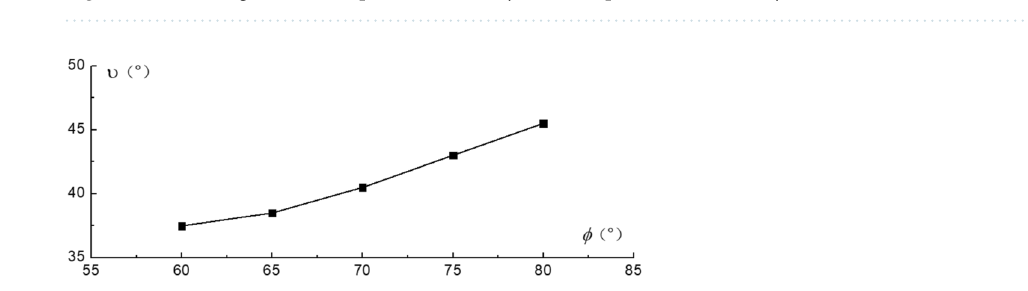
Figure 10. The diagram for comparison and analysis of computational results by different methods.